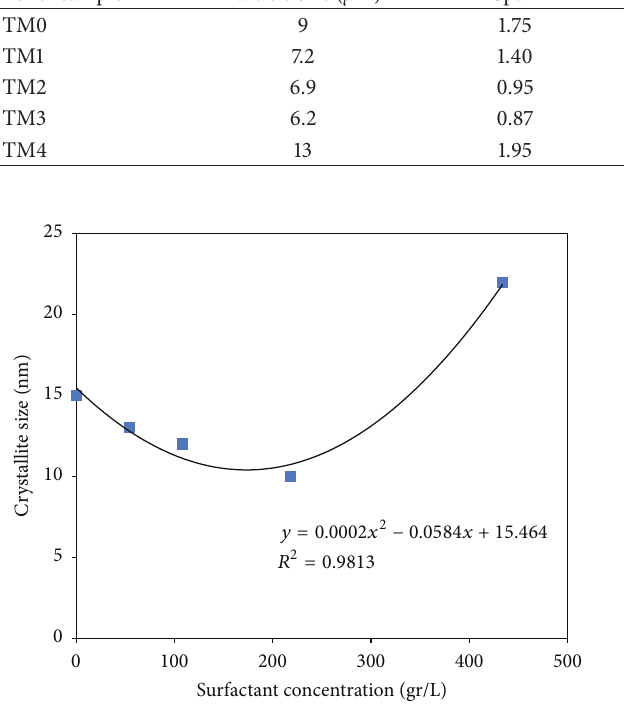
Figure 3: The average crystal size of synthesize Fe 3 O 4 particles with various amounts of surfactant by Sherrer’s equation.